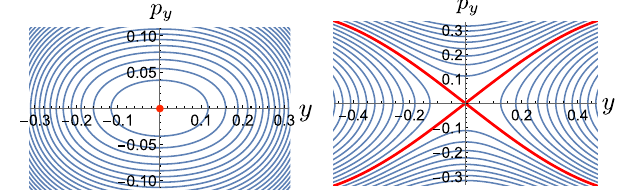
FIG. 5. Stable and unstable critical periodic orbits ( τ ¼ − 0 . 4 ). Contours of the function I j are shown on the surface S defined S by H ¼ H 0 , x ¼ 0 near the critical point (28). The periodic orbit of p pierces the surface S at the origin. (Left) The case H 0 ¼ 0 . 05 , for which p is stable. (Right) The case H 0 ¼ 0 . 5 , for which p is unstable. The visible portion of the level set containing p is shown in red.